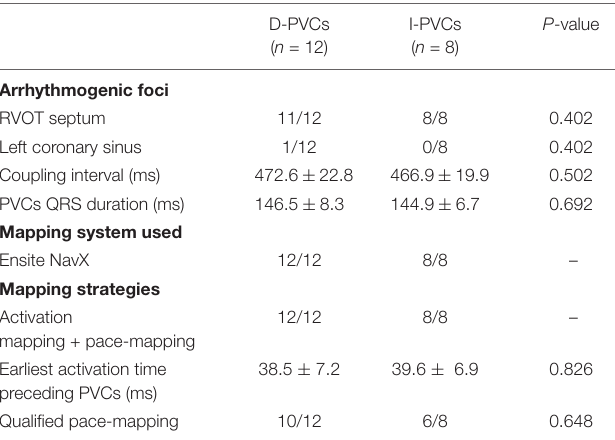
TABLE 3 | Electrophysiological features of PVCs in D-PVC and I-PVC patients.